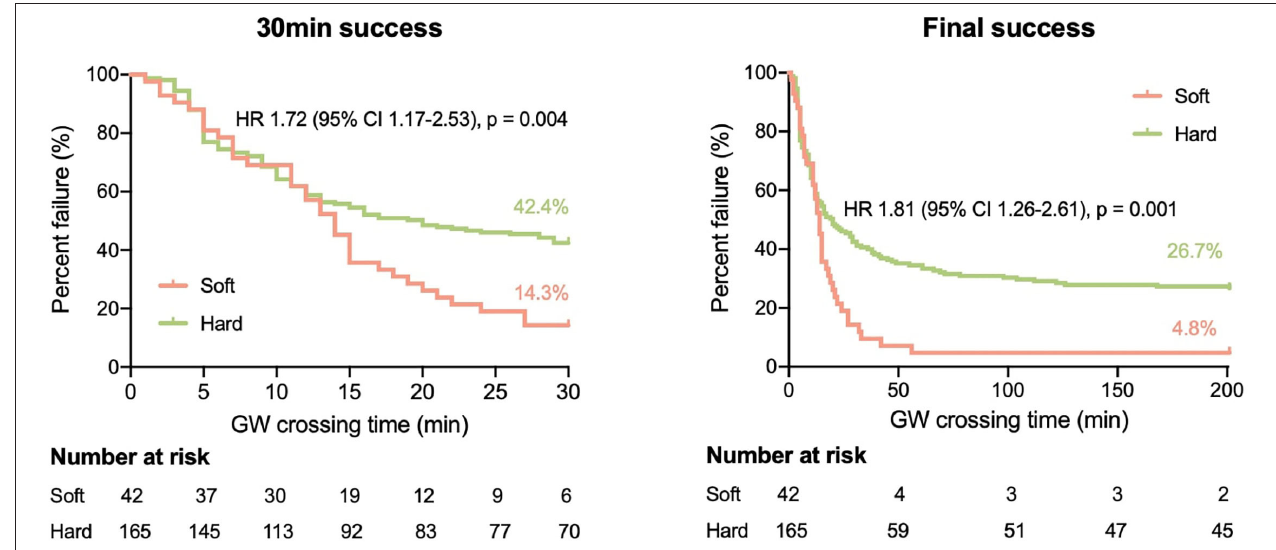
FIGURE 2 | Kaplan–Meier curves of successful 30min (left) and final (right) guidewire (GW) crossing in patients with soft and hard CTO.